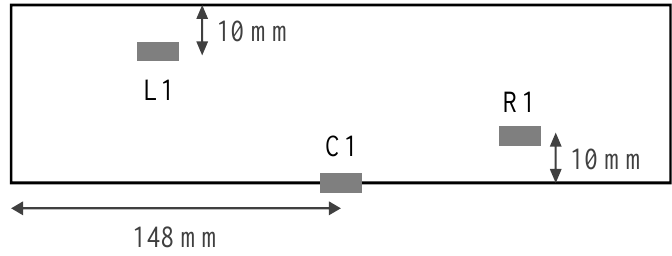
Figure 11. Strain gauge position on the rear side of the test specimen.